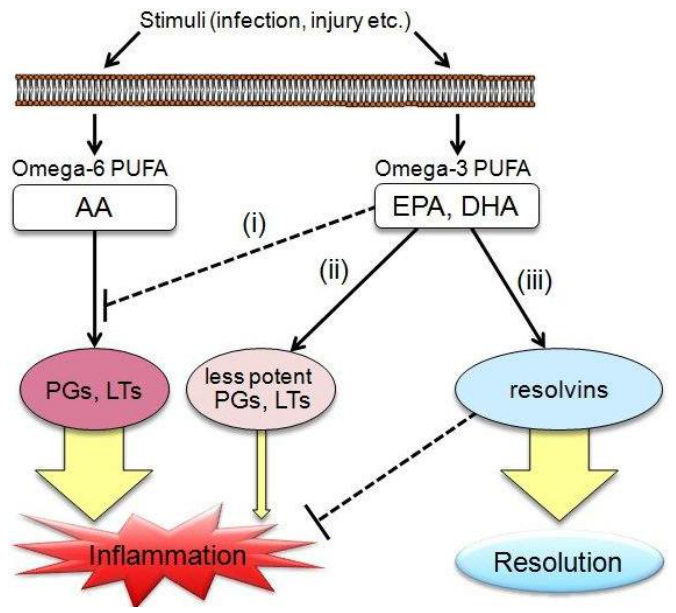
FIGURE 1. Possible mechanisms of the anti-inflammatory actions of ω-3 PUFAs. Omega-3 PUFAs are thought to act via several possible